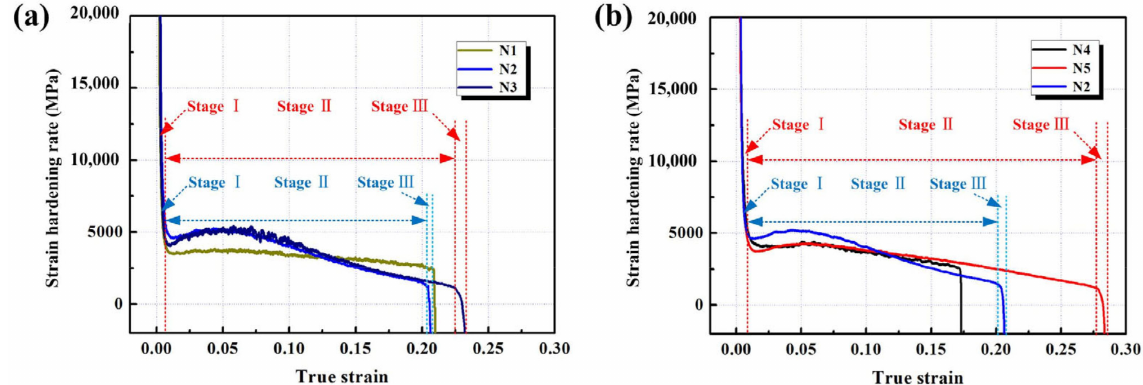
Figure 7. Work hardening rate curves of the sheet at room temperature for ( a ) N1, N2, and N3; ( b ) N4, N5, and